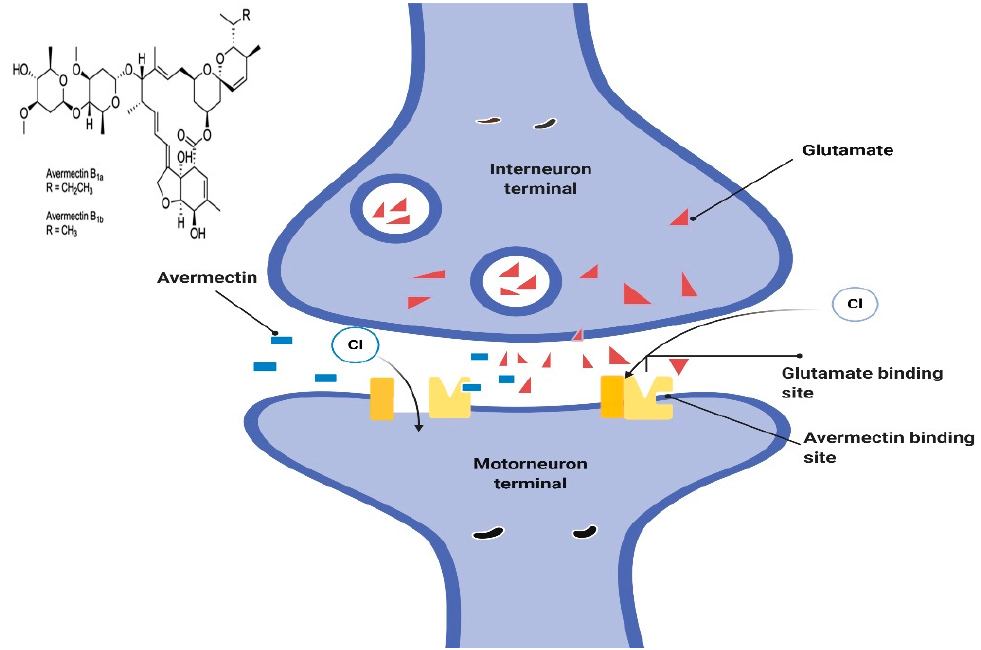
Figure 2. The proposed model to describe mechanisms of ivermectin sensitivity.